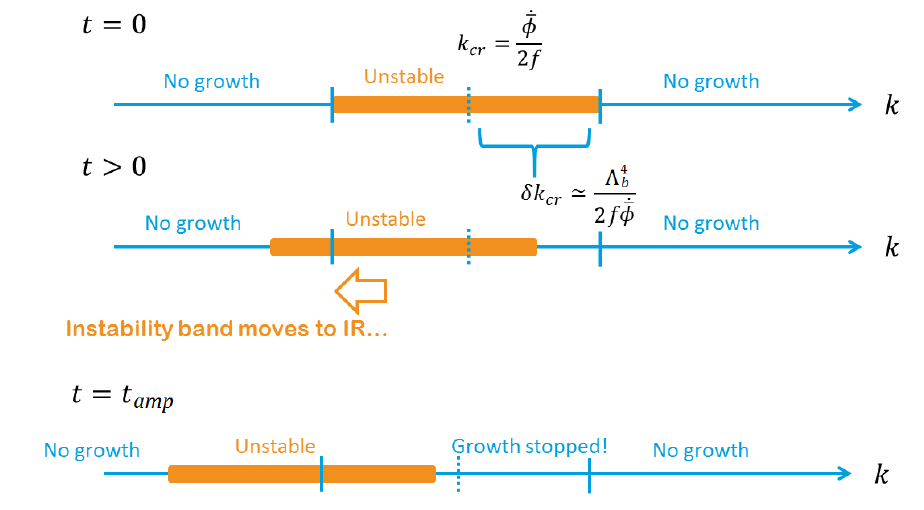
Figure 3 . Sketch of di(cid:11)erent time frames showing how the instability band moves due to particle production. For t = 0, j k (cid:0) k cr j . (cid:14)k cr is satis(cid:12)ed so there is an exponential growth of the (cid:13)uctuations for the mode k cr . Subsequently, the zero mode looses kinetic energy and the instability band starts moving towards smaller values of momentum. The exponential growth of mode with k cr stops when it moves beyond the instability